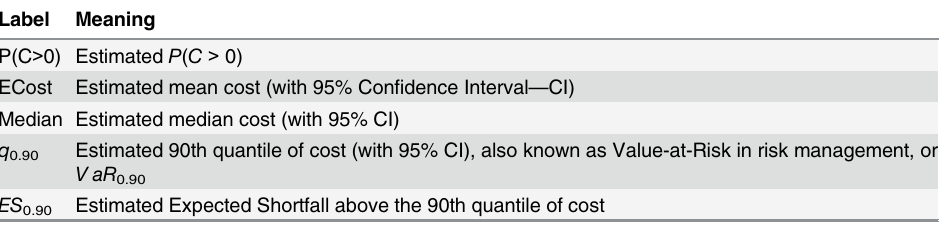
Table 15. Legend of quantities from the models for the monetary amounts ( “ costs ” for insurance companies). Label